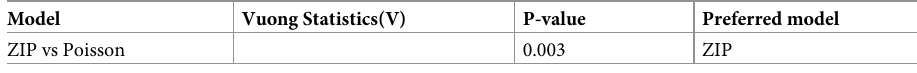
Table 3. Model comparisons using Vuong test for non-nested.